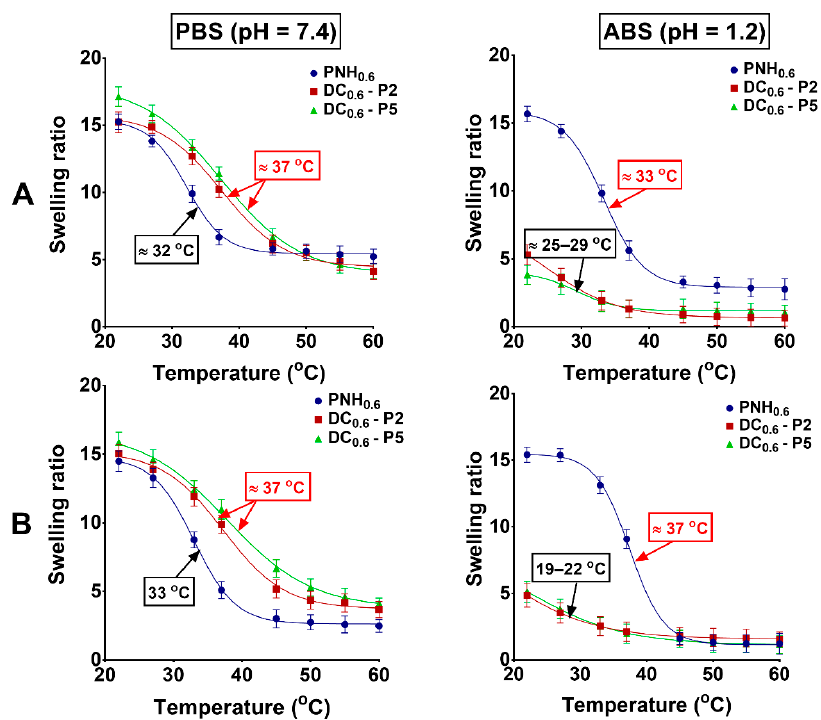
Figure 5. Swelling ratios of conventional and DC hydrogels as a function of temperature in the presence of Met at different concentrations: 1 mg/mL ( A ) and 5 mg/mL ( B ). The measurements were carried out in simulated physiological conditions (PBS at pH = 7.4 and ABS at pH = 1.2).